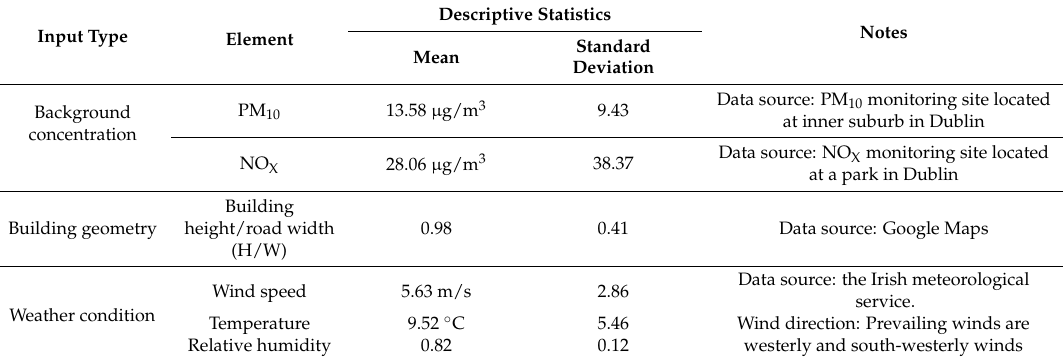
Table 3. Input data for background concentration, building geometry and weather